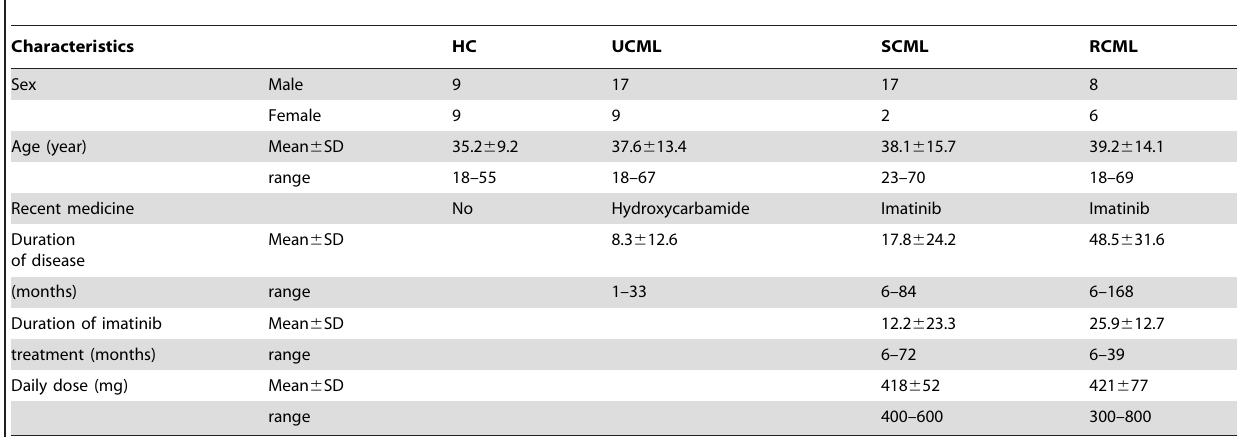
Table 1. Information of the CML patients and the health